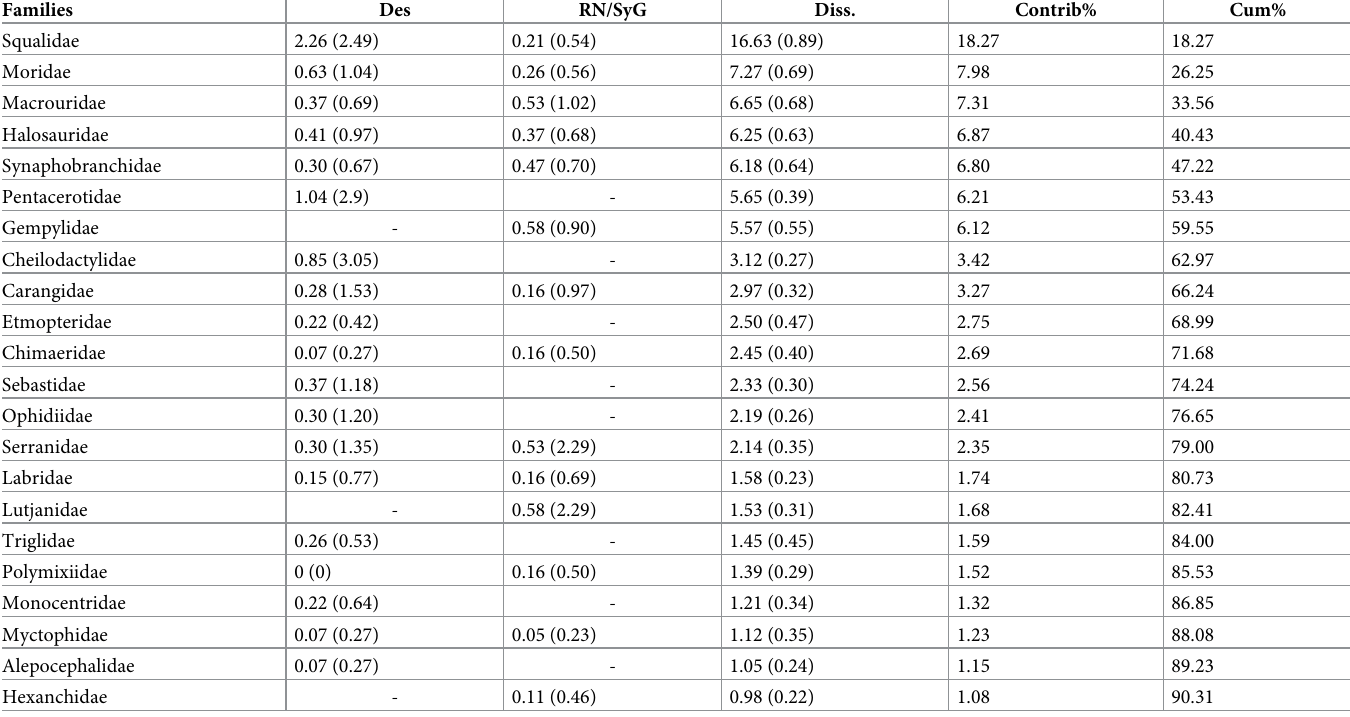
Table 2. SIMPER for fish families most responsible for the percent dissimilarities between subregions using Bray-Curtis similarity analysis of hierarchical agglom- erative group average clustering. Families